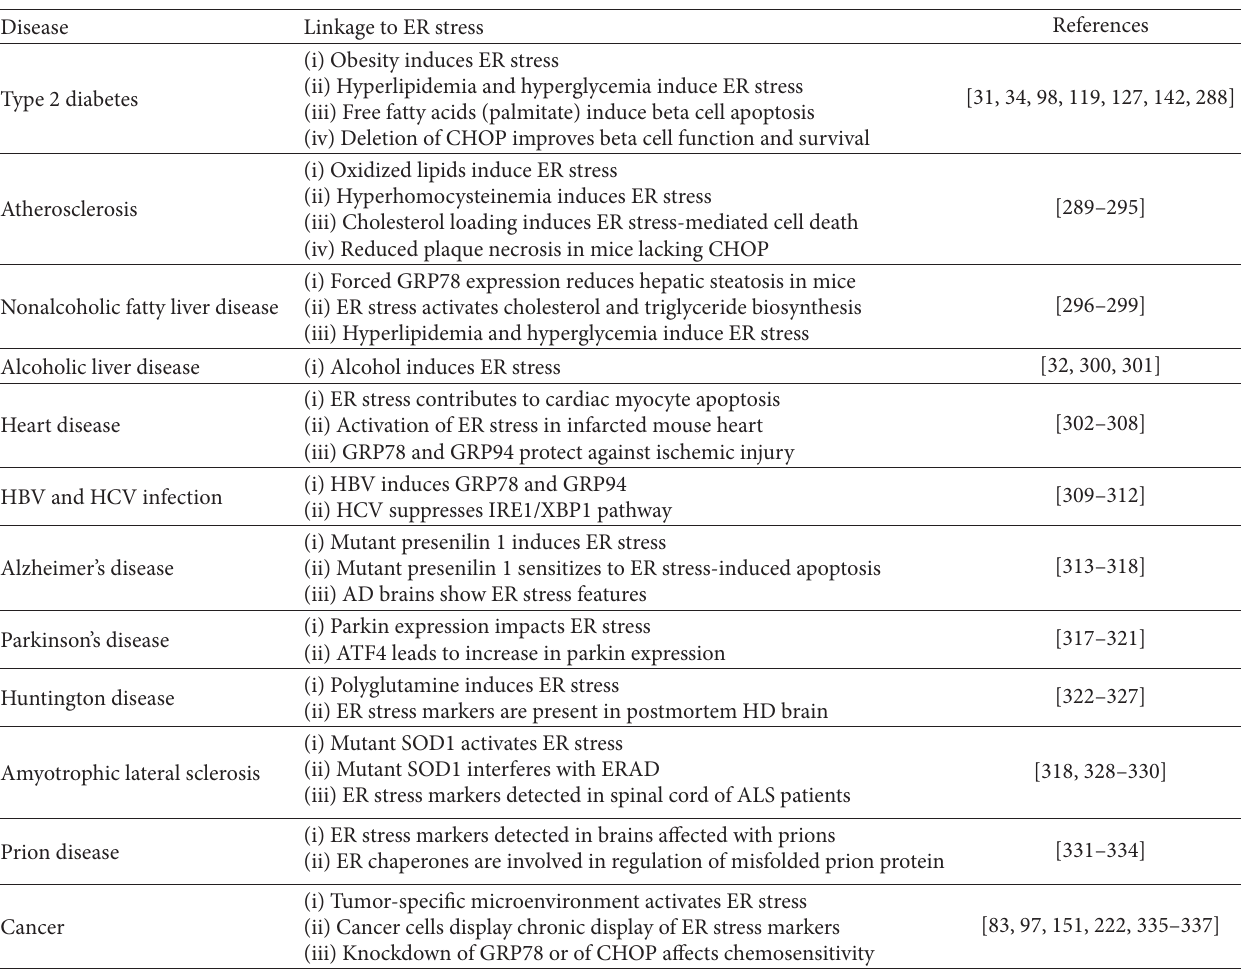
T 1: Human diseases linked to ER